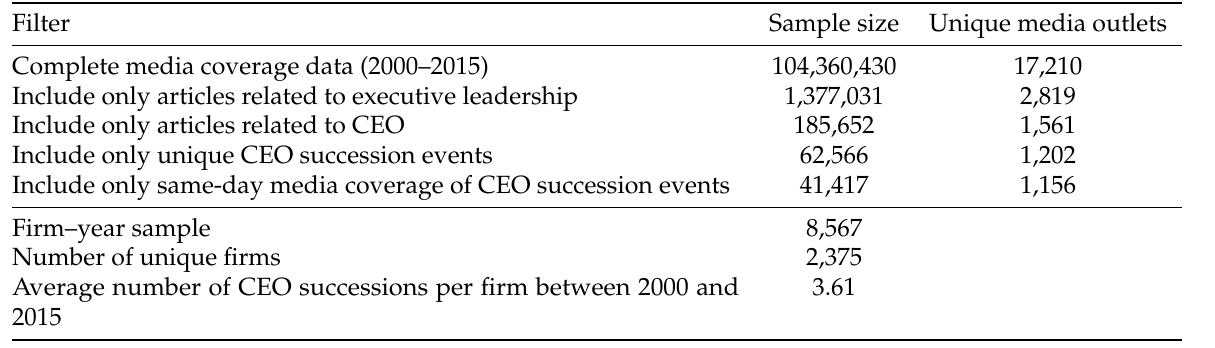
Table 1: Details of sample